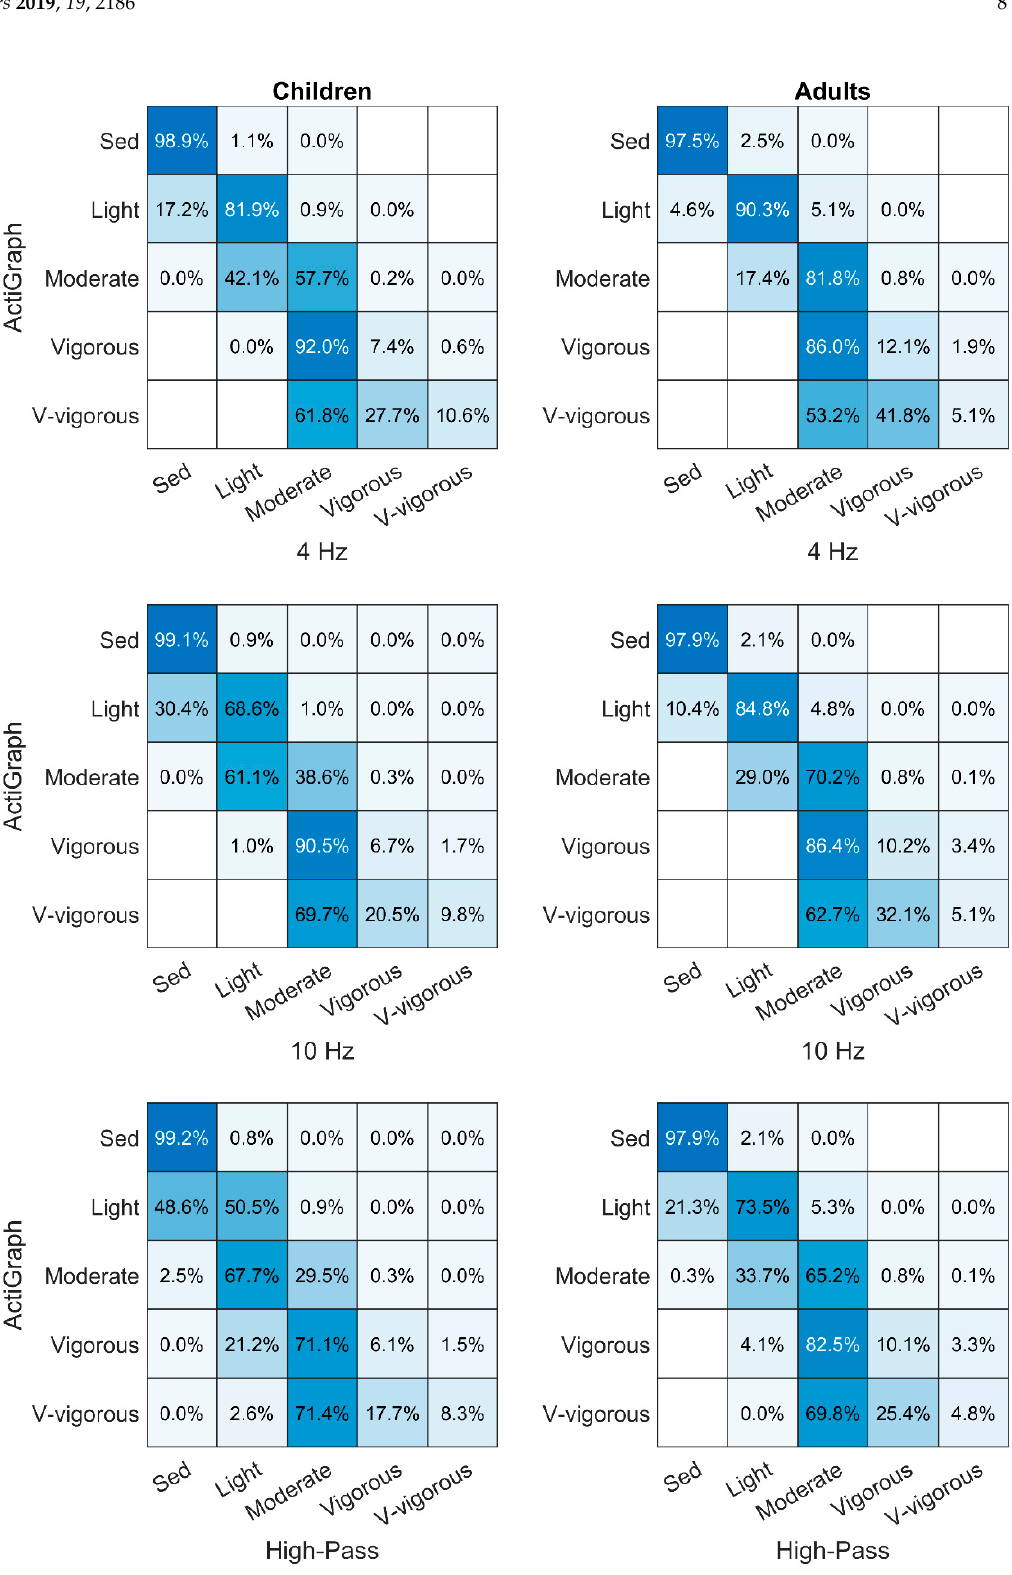
Figure 4. Row-normalized confusion charts comparing ActiGraph-filtered output with output from the modified filters epoch by epoch. Numbers on the diagonal from the upper left to lower right corner with 100% would indicate a perfect agreement between the filters whereas numbers in the lower or upper triangles from the diagonal indicate that the modified filters classify the activity intensity as lower or higher, respectively.